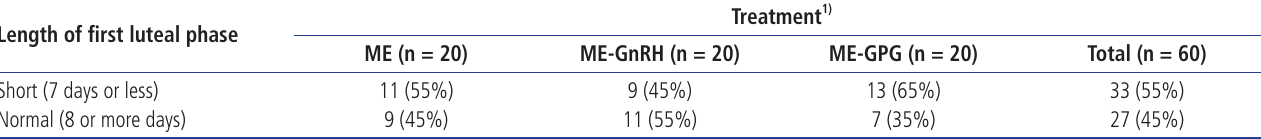
Table 2. Classification of the anestrous Suffolk ewes of the second experiment according to the length of the first luteal phase after they were exposed to different treatments Length of first luteal phase